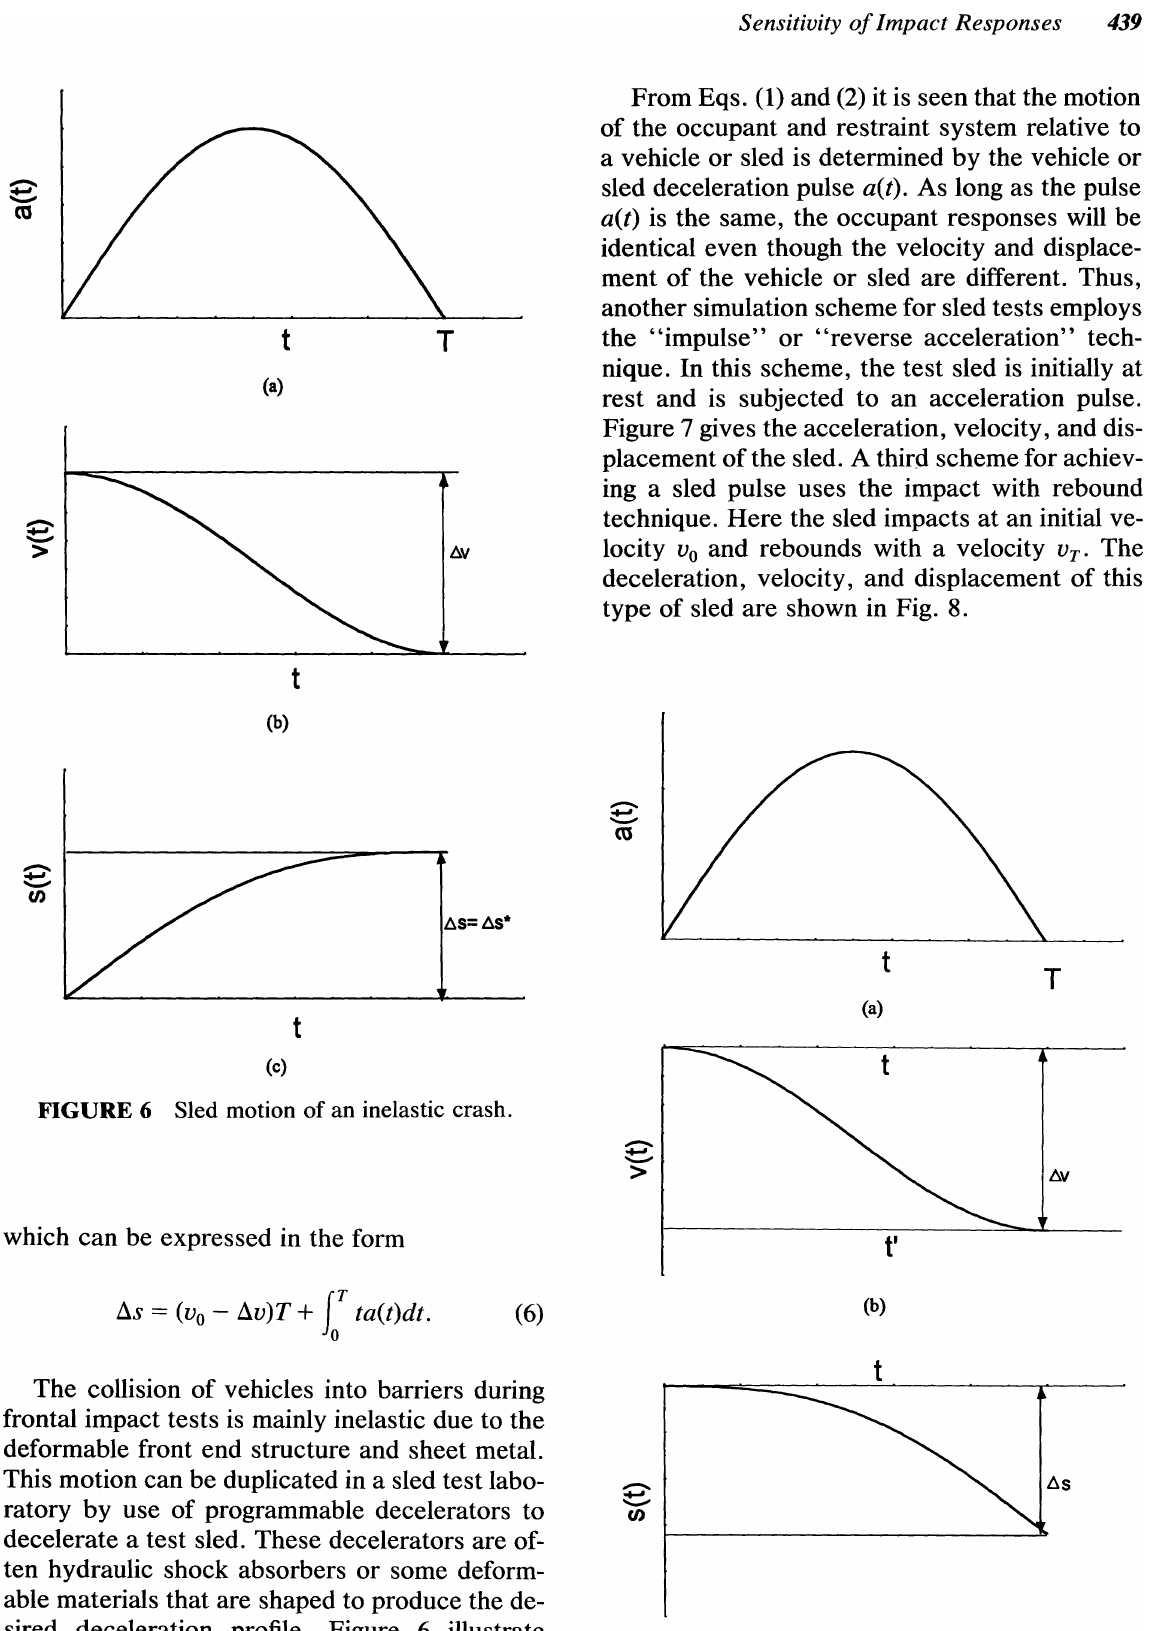
FIGURE 7 Sled motion of an impulse